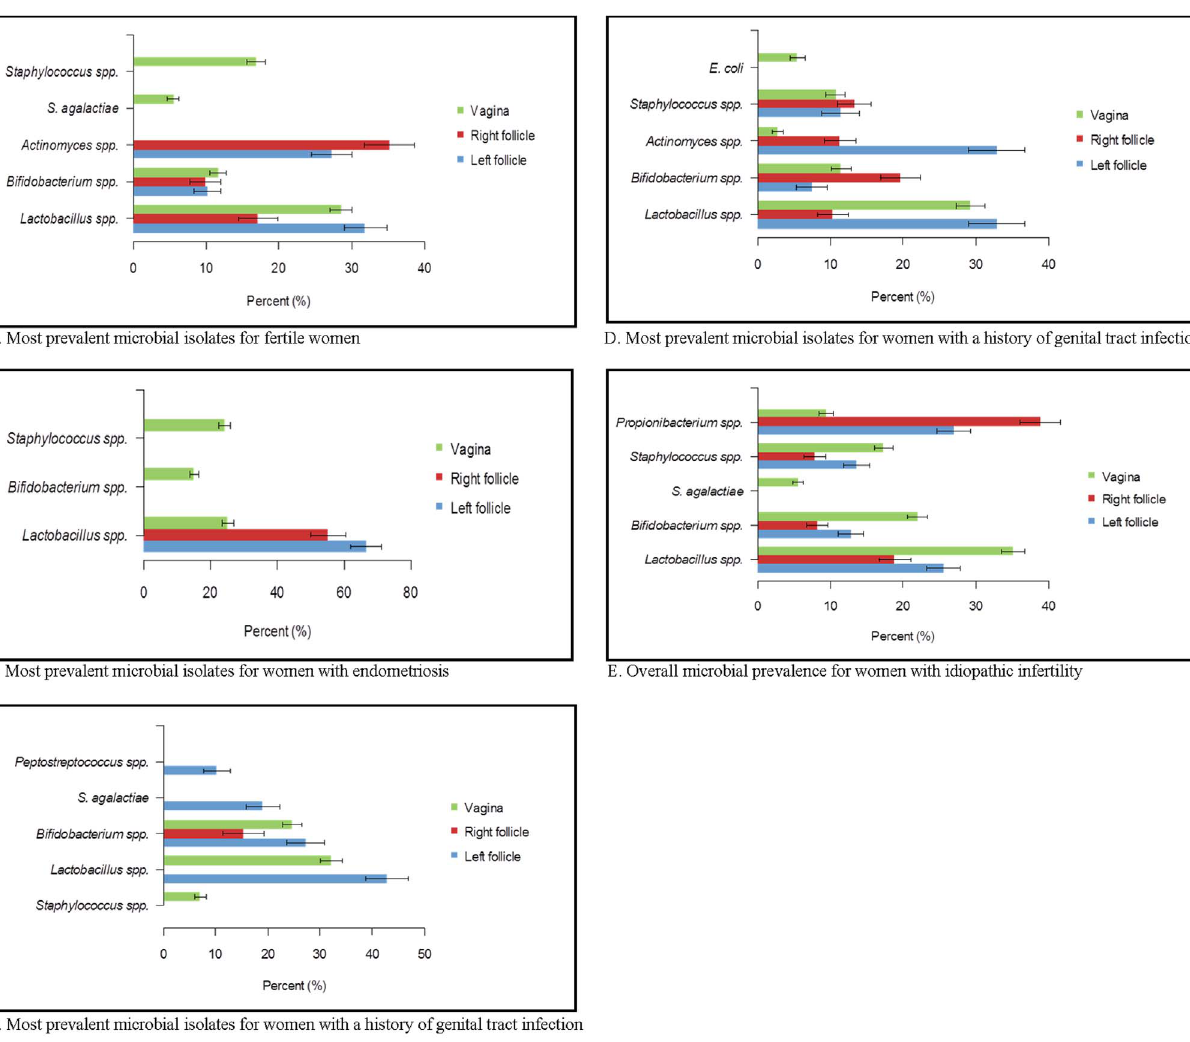
Figure 1. The most prevalent microbial species detected from the left and right follicular fluids and vagina from women in this study. 1 A–E The most prevalent microbial species detected from the left and right follicular fluids and vagina from women in this study are stratified based on the diagnosed cause of infertility. Bars represent one standard error.